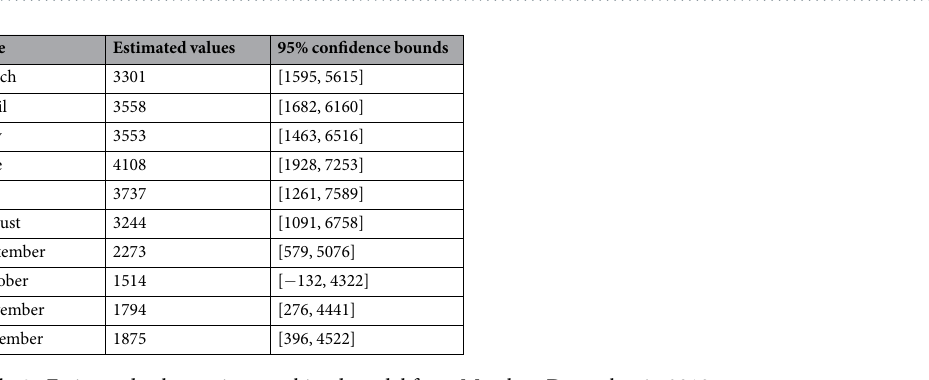
Figure 6. Comparison observations of in-sample fitting and out-of-sample forecast among selected models. The shaded area represents the incidence cases from March 2018 to December 2018 projected by the best- performing hybrid method, suggesting that a downward trend will continue to be observed in the near future.